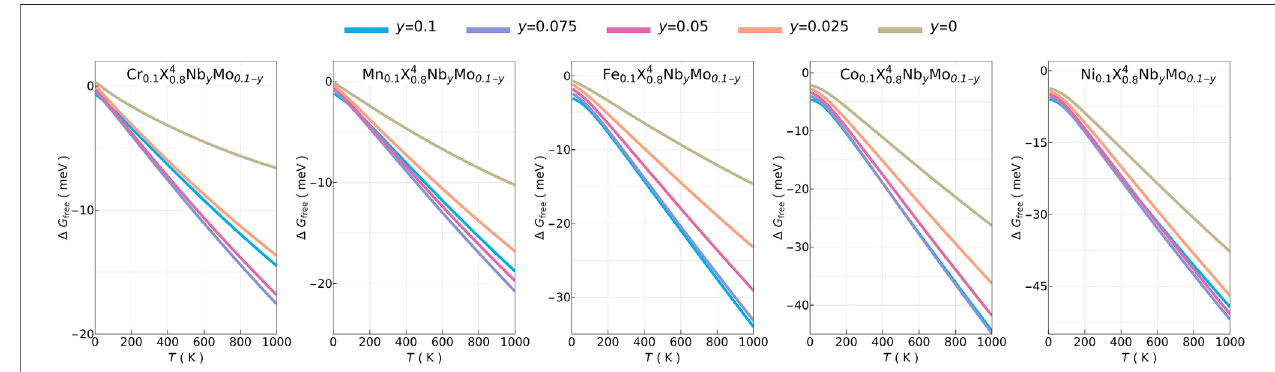
FIGURE 3 | Temperature dependence of Gibbs free energy differences of non-equimolar six- and seven-principal-elements high-entropy alloys with respect to CrMnFeCoNi (X 5 ).